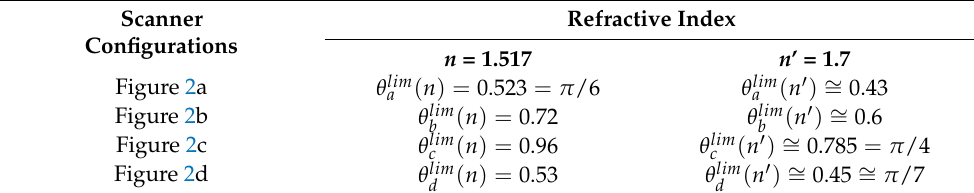
( rad ) , j = a , b , c , d with regard to refractive index (the identical Table 2. Limit prism angle θ lin j prisms case, i.e., k =